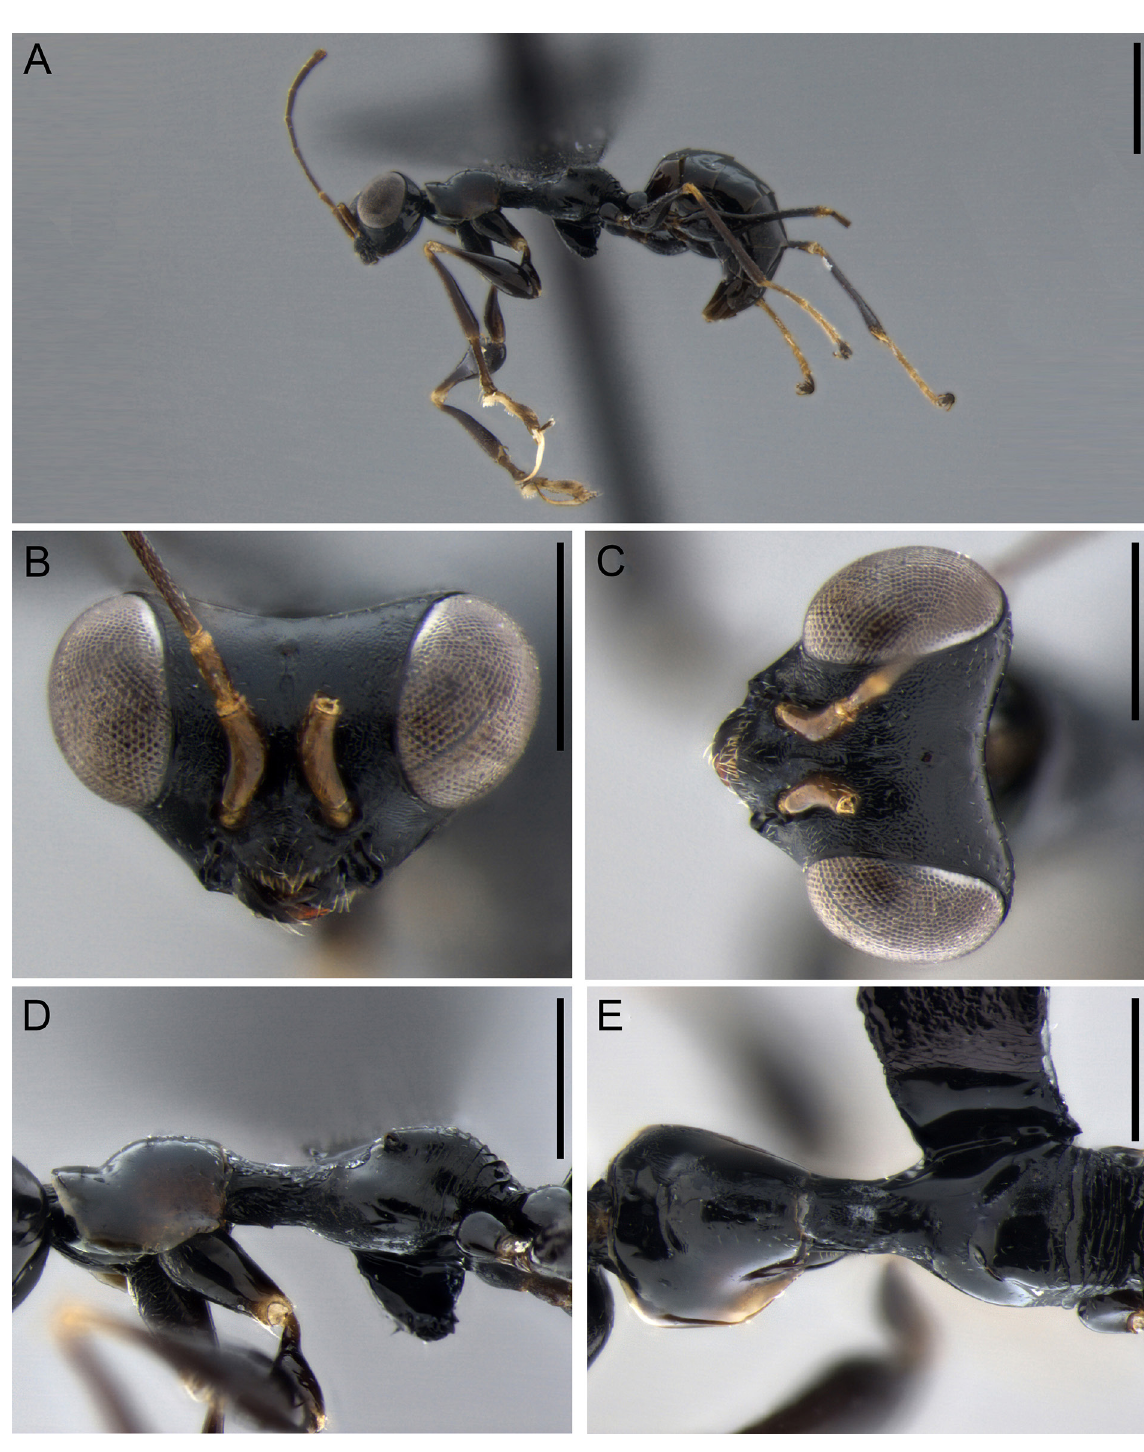
Fig. 5. Pareucamptonyx niger Martins sp. nov., holotype, ♀ (DZUP). A . Habitus, lateral view. B . Head, frontal view. C . Head, dorsal view. D . Mesosoma, lateral view. E . Mesosoma, dorsal view. Scale bars =